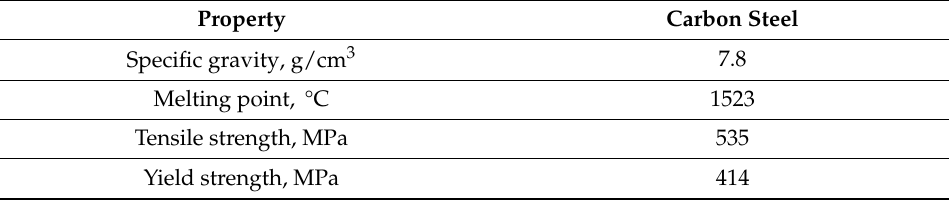
Table 2. Material Property of carbon